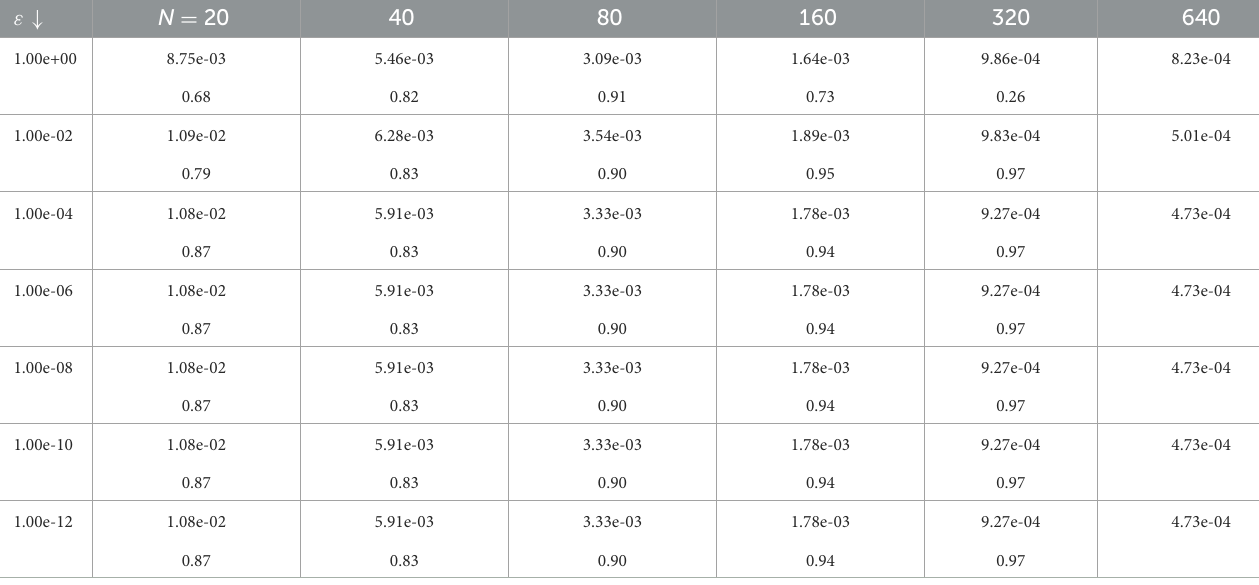
TABLE 5 Maximum absolute errors for Example 4.2 for M = 32 at the number of intervals N .